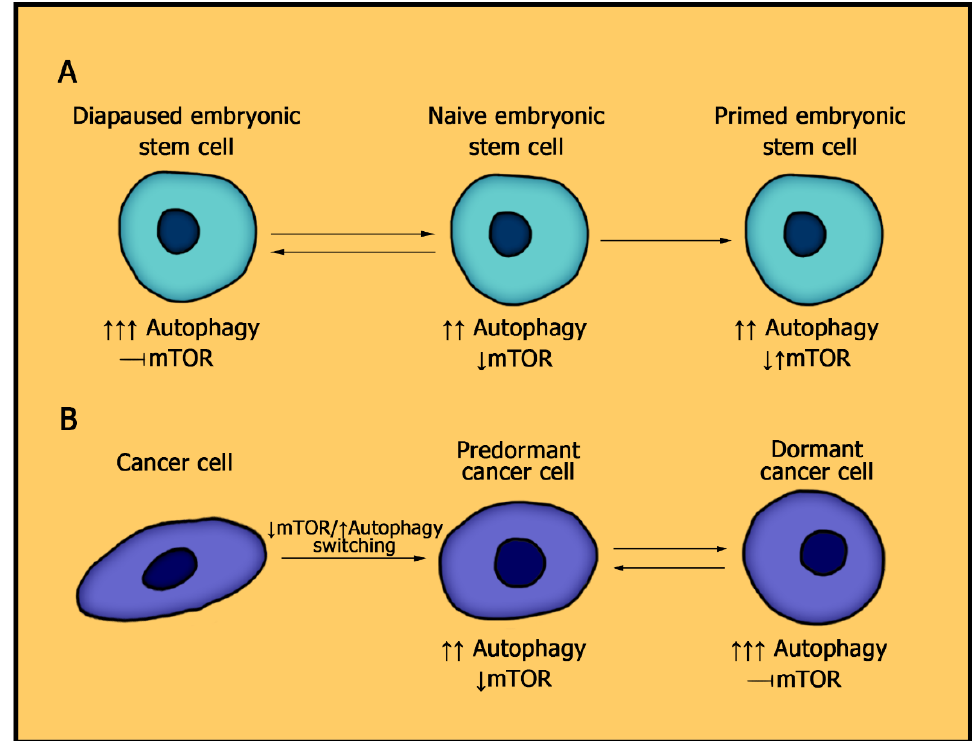
Figure 1. Schematic of review concept. Embryonic stem cells (ESCs) can be exposed to diapause—a prolonged stop of proliferation, followed by its resumption under favorable conditions. Naive ESCs can be isolated from diapaused embryos of mice and, therefore, give rise to all cell types of adult organisms, while primed ESCs obtained from human embryos are more differentiated and have more limited regenerative potential. The low mechanistic target of rapamycin (mTOR) activity in ESCs is correlated with a high autophagy flux, which is more upregulated in naive ESCs. Primed ESCs cannot be exposed to diapause due to the absence of a permissive mTOR signaling profile; in other words, due to inconsistency of signaling pathways converging on the mTOR pathway downregulation. The mechanisms of mTOR suppression are permitted for naive ESCs entry into diapause. Based on the above, we can assume that a similar principle also works in the formation of cancer cell dormancy.